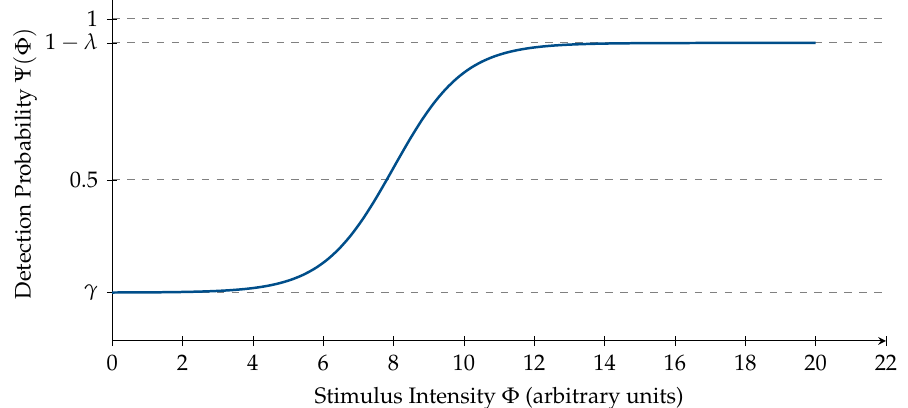
Figure 1. Sample psychometric function Ψ ( Φ ) with location parameter α = 8, sensitivity parameter β = 1, corrected guess rate γ = 0.15 and lapse rate λ = 0.075. A stimulus with intensity Φ = α = 8 is detected in 50% of all trials. For discrimination tasks, the relation between test and reference stimulus is often used as stimulus Φ